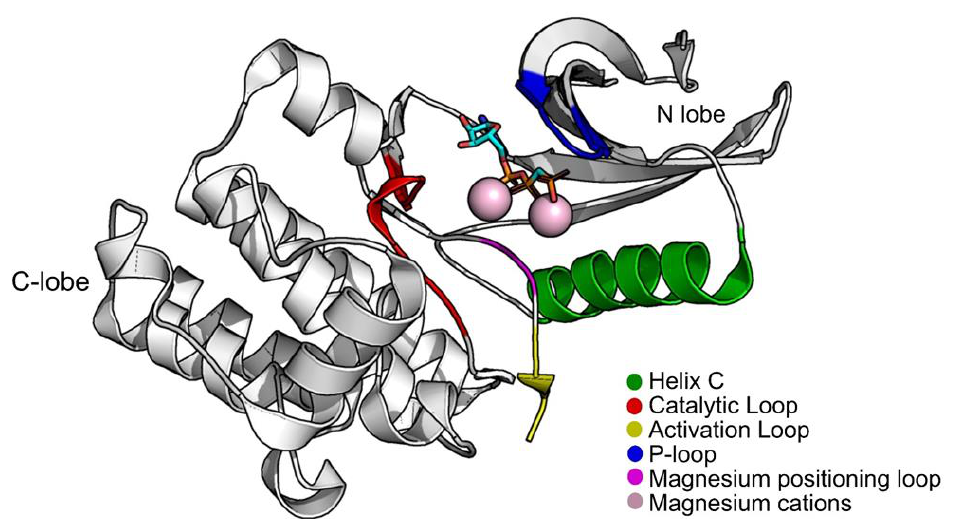
Figure 1. Structure of PknB (PDB:1O6Y) with groups that are important for its activity highlighted. Figure was produced using Pymol.